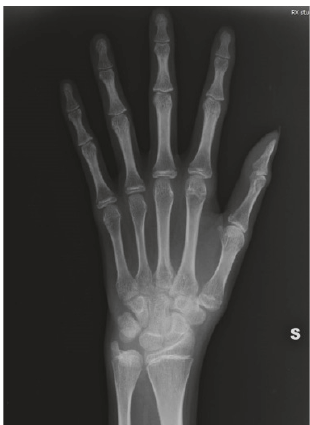
Figure 2: Left hand and wrist X-ray. The ossification of the epiphysial cartilage of distal end of radius and ulna, 1st metacarpus, and phalanxes is not yet complete.